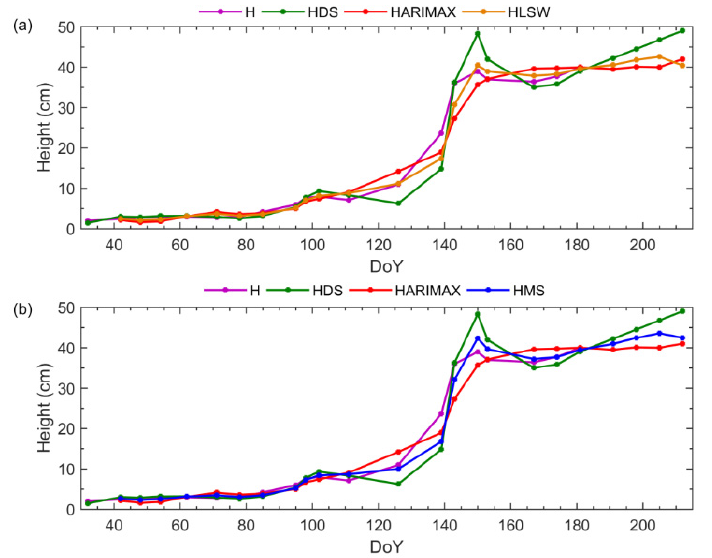
Figure 3. Combination prediction for height: ( a ) weighted least squares; ( b ) mean squared. H: interpolated data; HDS: double smoothing; HARIMAX: ARIMAX; HLSW: weighted least squares; HMS: mean squared.